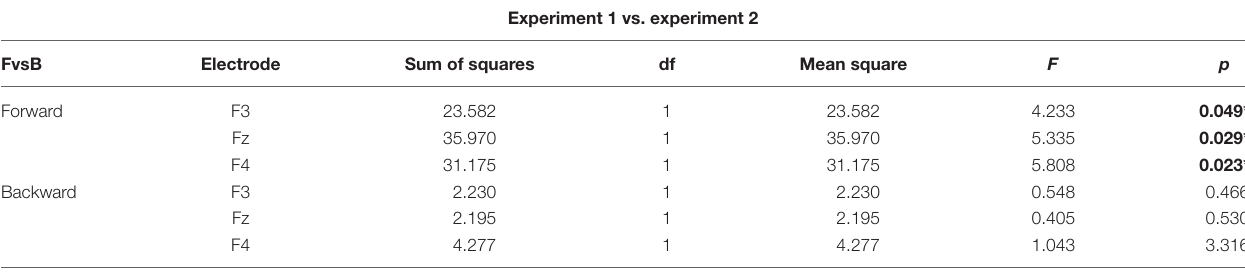
TABLE 2 | Simple main effects of forward vs. backward displaying of bilabial syllables.